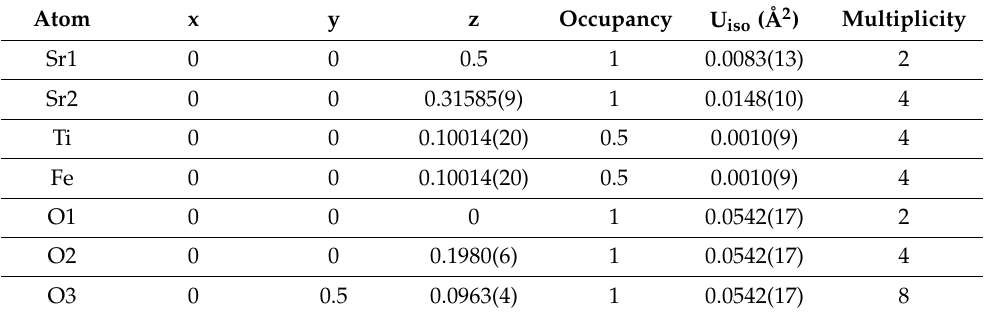
Table 3. Refined structural parameters of Sr 3 TiFeO 7 − δ from powder X-ray diffraction data. Space